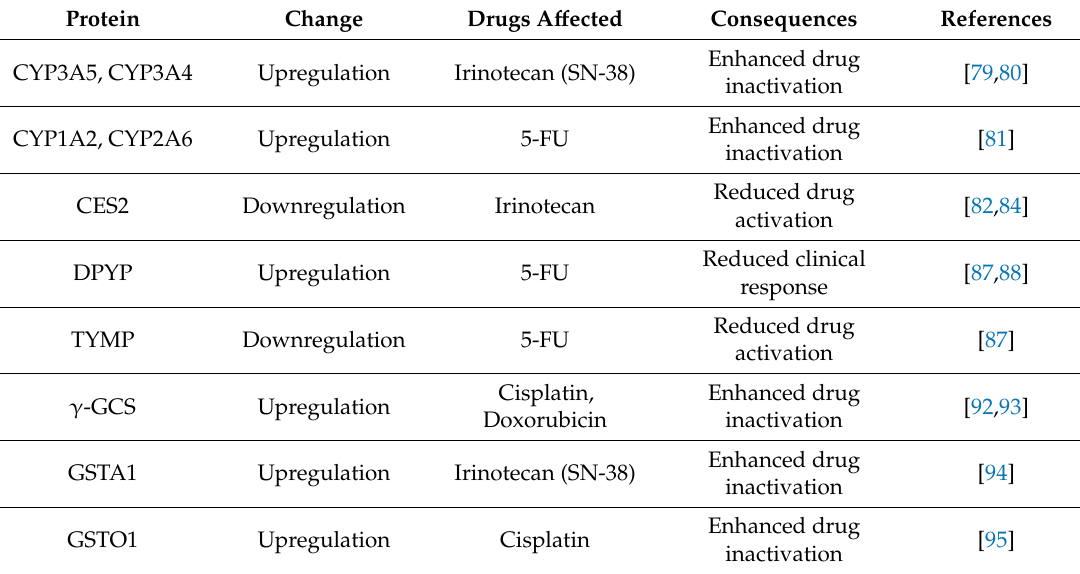
Table 2. Mechanisms of chemoresistance type 2 (MOC-2) in colorectal cancer.